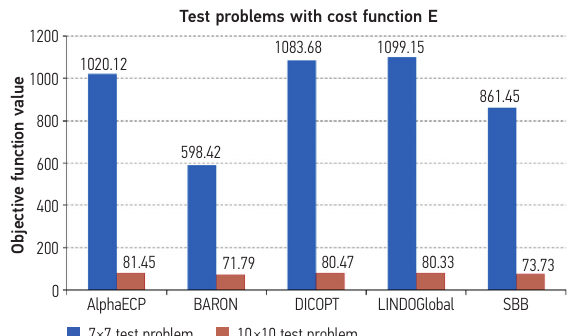
Fig. 6. Objective function values for test problems with cost function E